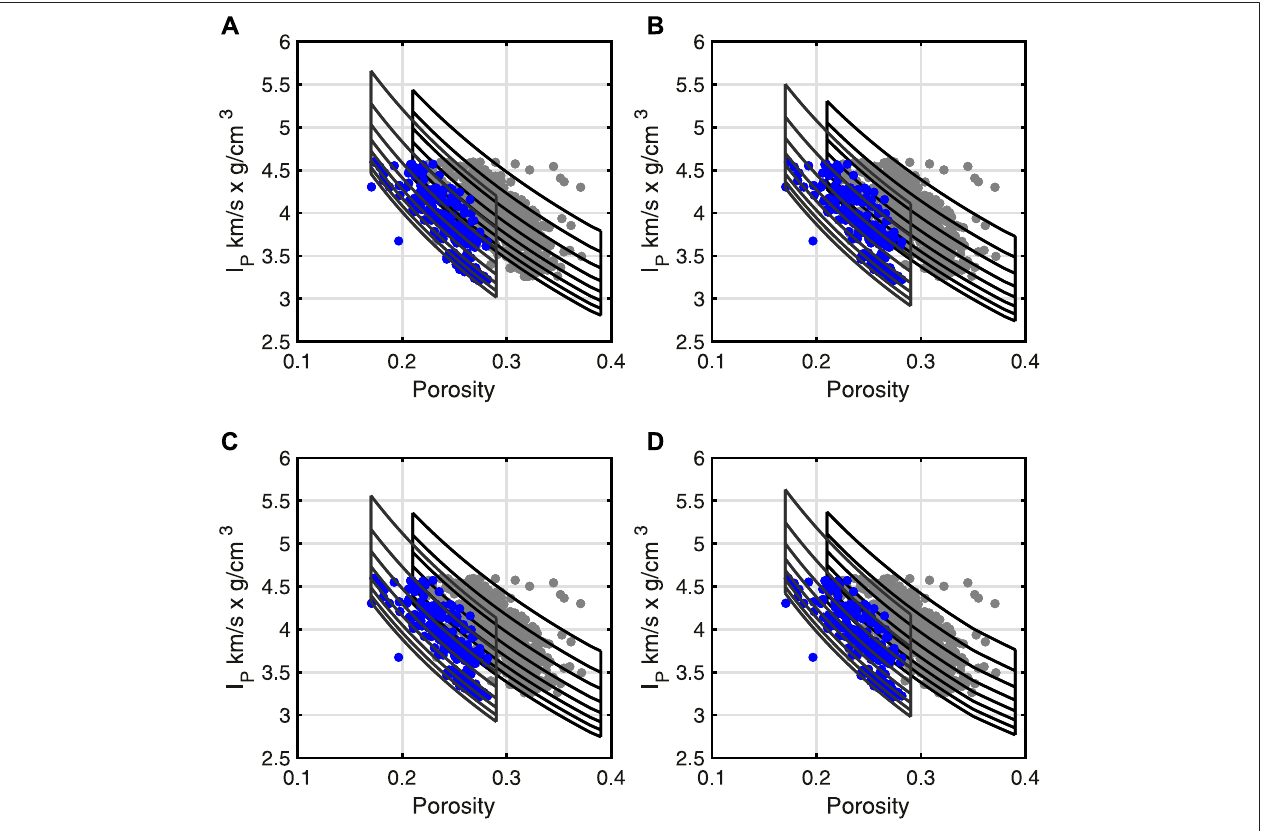
FIGURE3| Thefour plotscontainperturbed versionsoftherock physics modelsin Figure2 .Theoil sandsareingray pointsand gassandsinblue. Themodels in (A) are thesameasthose in Figure 2A . Thecomposition wasaltered slightlyin (B) relative to (A) . In (C,D) thepressureand critical porosity, respectively, werechanged relative to the models in (A) . All four sets of models match the data from a qualitative perspective.